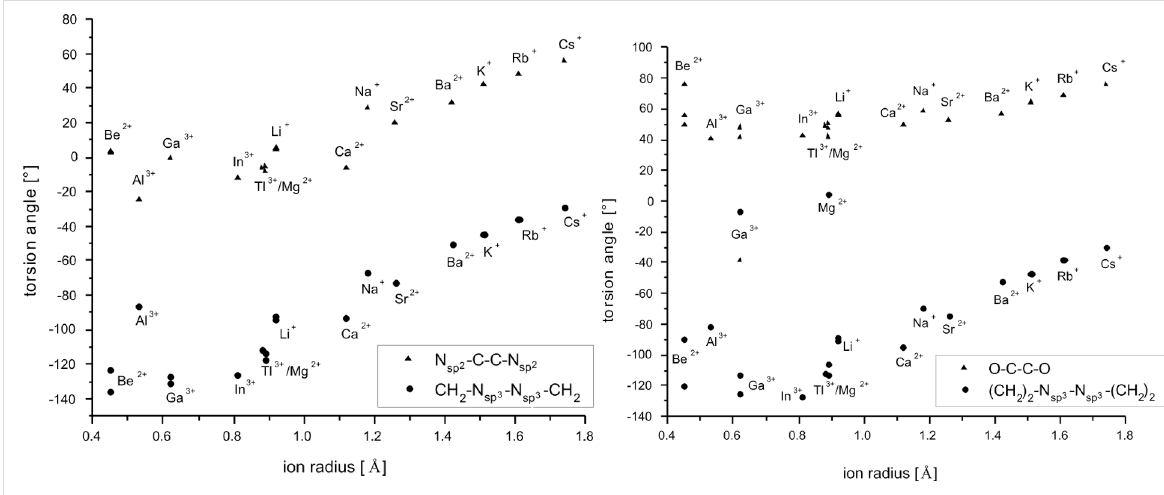
Figure 15: Reverse development of the calculated torsion angles on the respective cryptate sides for [2.2.bpy].